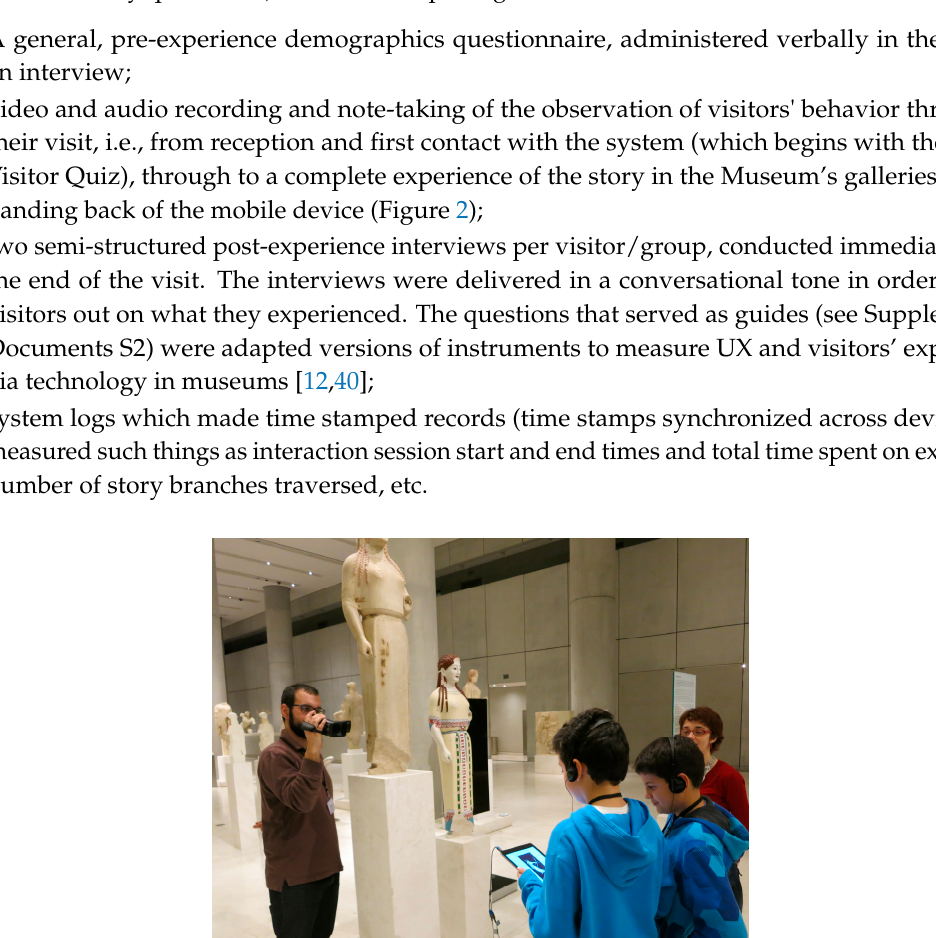
Table 1. Numbers and ages of participants in evaluation